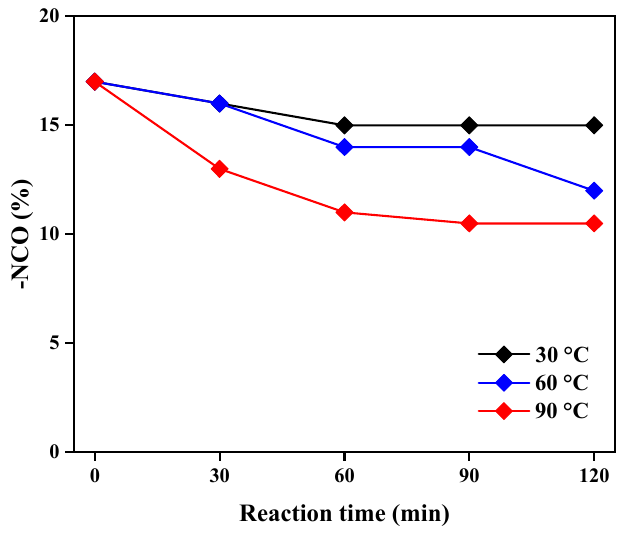
Figure 5. Changes in the –NCO group content with the reaction time and temperature.